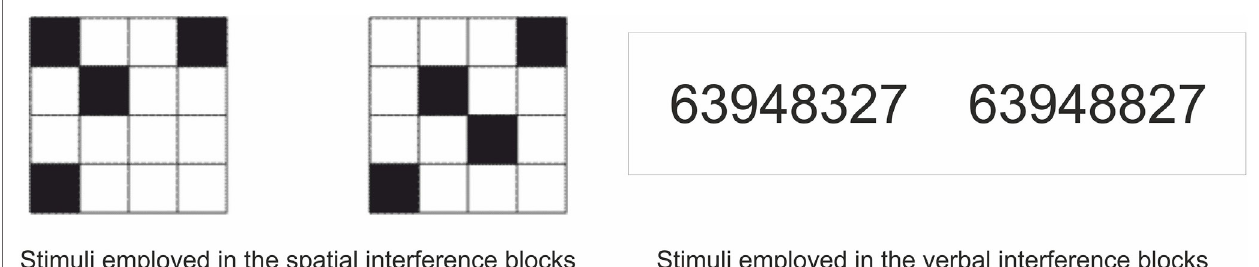
FigUre 3 | Example of stimuli employed in the spatial interference block (left), and in the verbal interference block